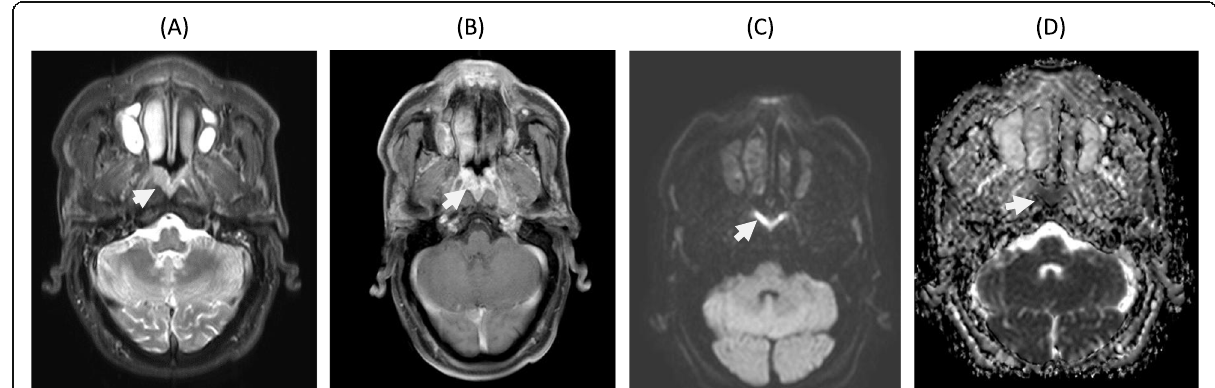
Fig. 4 Pathologically proven post-treatment benign changes following chemoradiation for nasopharyngeal carcinoma. In this case, biopsy and histopathological examination revealed tissue fibrosis with no malignancy. However, the lesion was falsely diagnosed by diffusion-weighted imaging (DWI), i.e. wrongly interpreted as “ locoregional recurrence/residual tumour ” . a Axial T2-weighted image (T2WI) showing an area of diffuse thickening within the posterior nasopharyngeal wall, being more prominent on the right side, with intermediate signal intensity. b Axial T1- weighted image (T1WI) post-contrast sequence showing inhomogeneous enhancement of the lesion. c Diffusion-weighted imaging (b1000) revealing the hyperintense pattern of the lesion. d Apparent diffusion coefficient (ADC) map revealing the hypointense pattern of the lesion, with